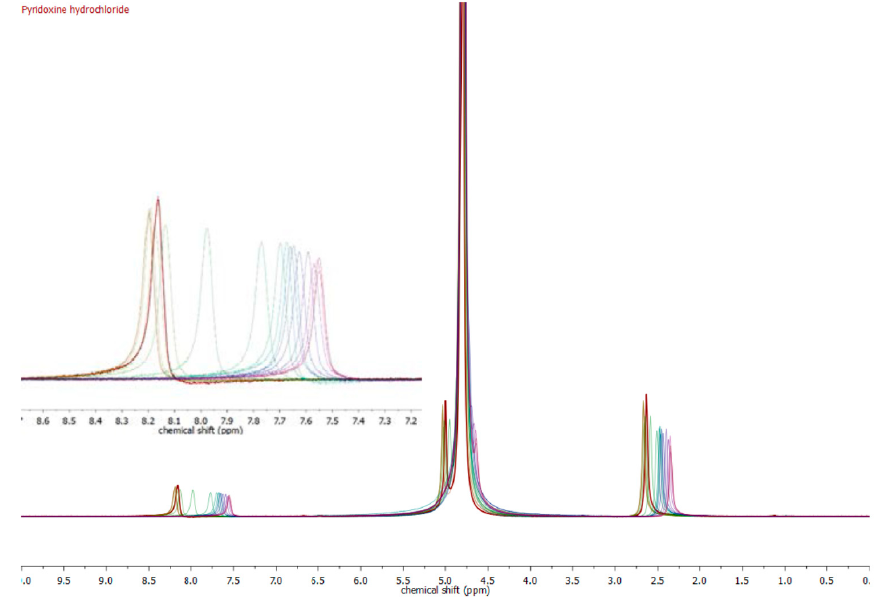
Figure 3. Stacked 1 H NMR spectra of pyridoxine at different pH values (starting conc. 20 mg/mL) showing full-scale and enlarged region of interest.